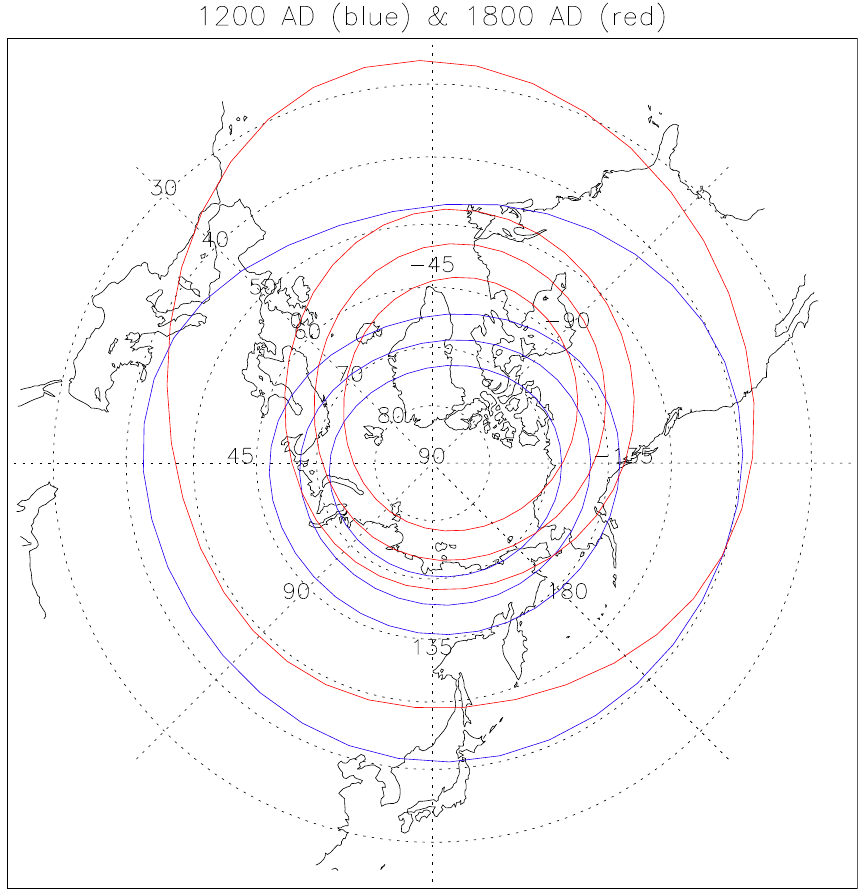
Fig. 5. Estimated global shape of the auroral zone in 1200 AD (blue) and 1800 AD (red). Contours are apex fi eld intensities of 49, 173, 474, and 6178 nT, corresponding to 70, 65, 60, and 40 magnetic latitudes. Japan ’ s longitude (135 E) is toward the